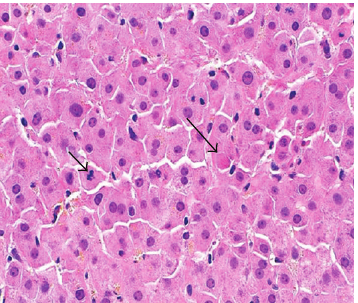
Figure 1: H&E stain at 400x shows mild acute hepatitis with rare acidophil bodies (long arrow) and increased mitotic figures (short arrow) in the hepatic